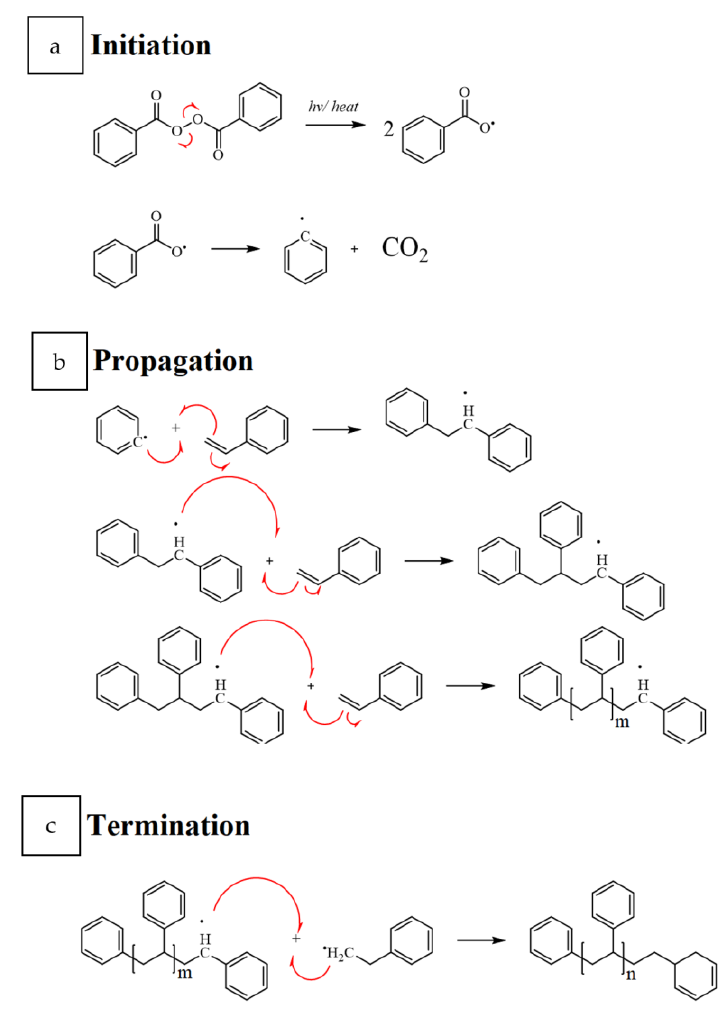
Figure 2. Benzoyl peroxide-initiated polymerization of PS.